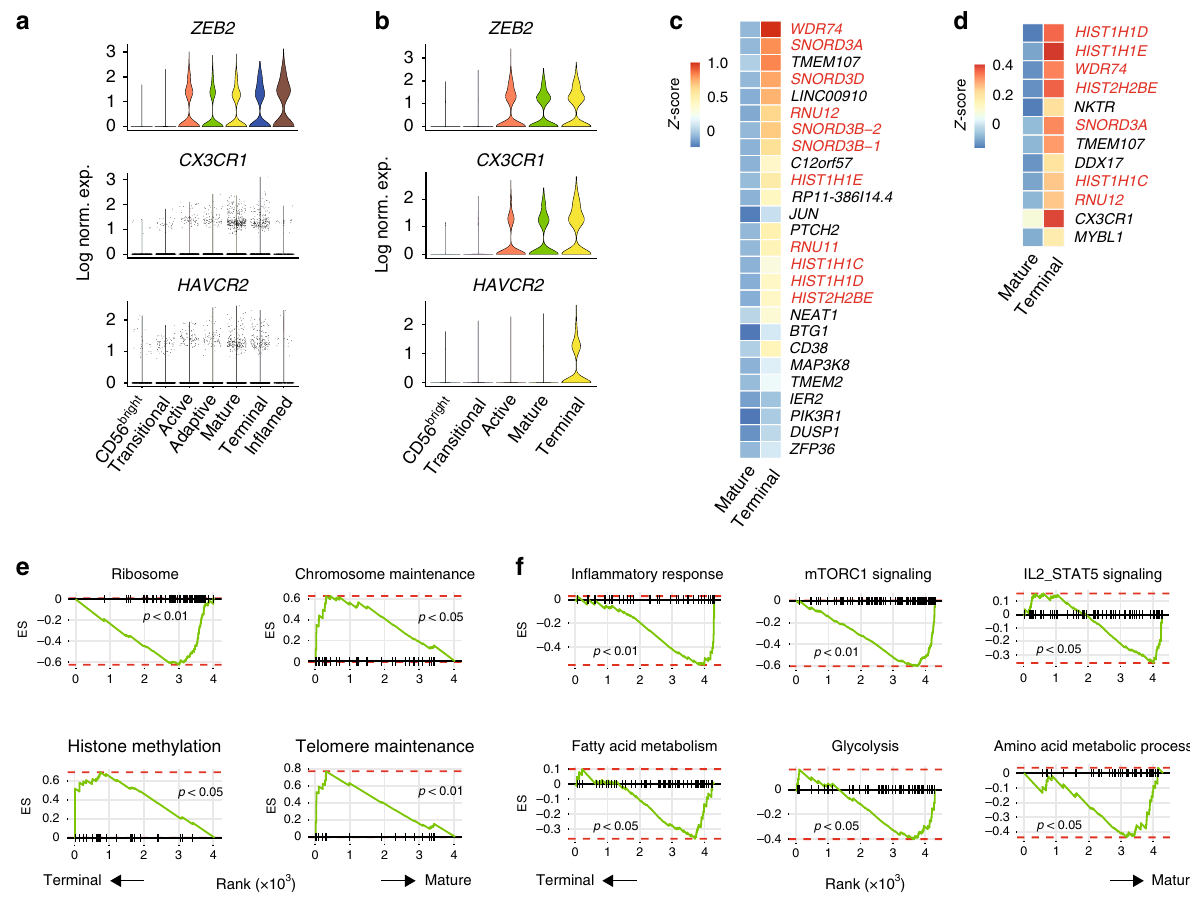
Fig. 7 Unique transcriptional pro fi le of terminally differentiated NK cells. a , b The expression of ZEB2 , CX3CR1 , and HAVCR2 in each cluster of the BM ( a ) and blood ( b ) samples were shown as violin plots. The y -axis represents log-normalized expression value. c , d The expression of all the DEGs between “ Mature and Terminal NK ” cluster of the BM ( c ) and blood ( d ) samples were plotted via heatmap. Genes related to histones or ribosomes were highlighted in red. e Selected gene sets enriched in the “ Terminal NK ” cluster compared to the “ Mature NK ” cluster of BM sample. f Signaling and metabolic gene sets were reduced in the “ Terminal NK ” cluster compared to the “ Mature NK ” cluster of the blood sample. See also Supplementary Fig.